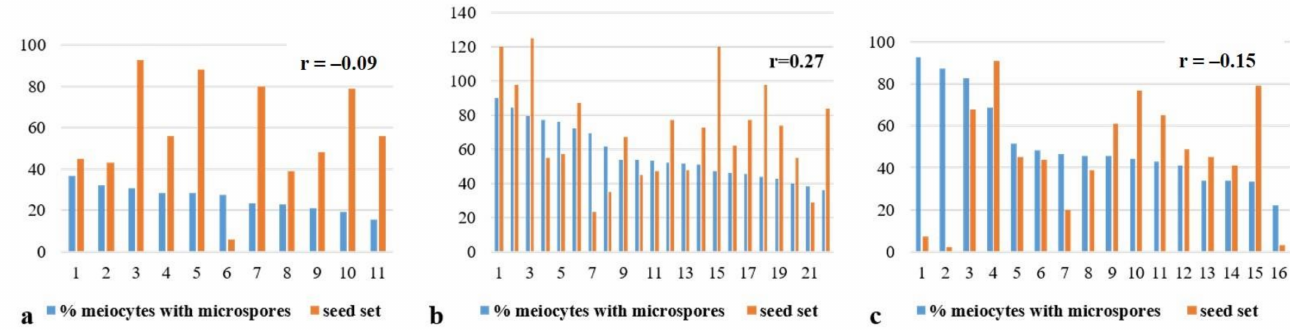
Figure 14. Absence of correlation between the frequency of micronuclei in meiosis and the seed set: ( a) Subgroup 1a, 22-4 plant progeny; ( b ) subgroup 1b, 23-8 plant progeny; ( c ) subgroup 1b, 23-10 plant progeny. r—correlation